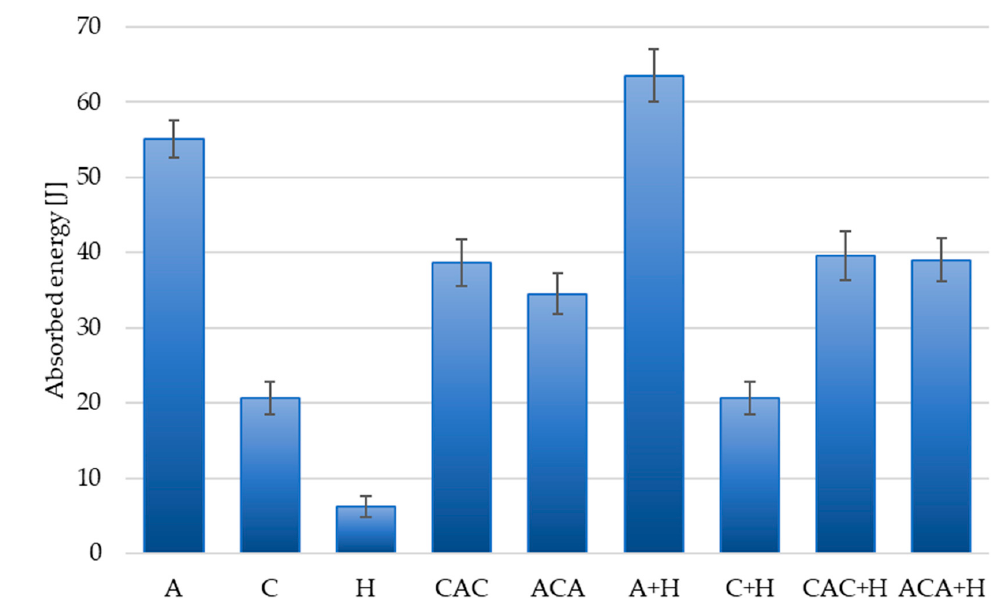
Figure 8. Total energy absorption of hybrid and non-hybrid composites.